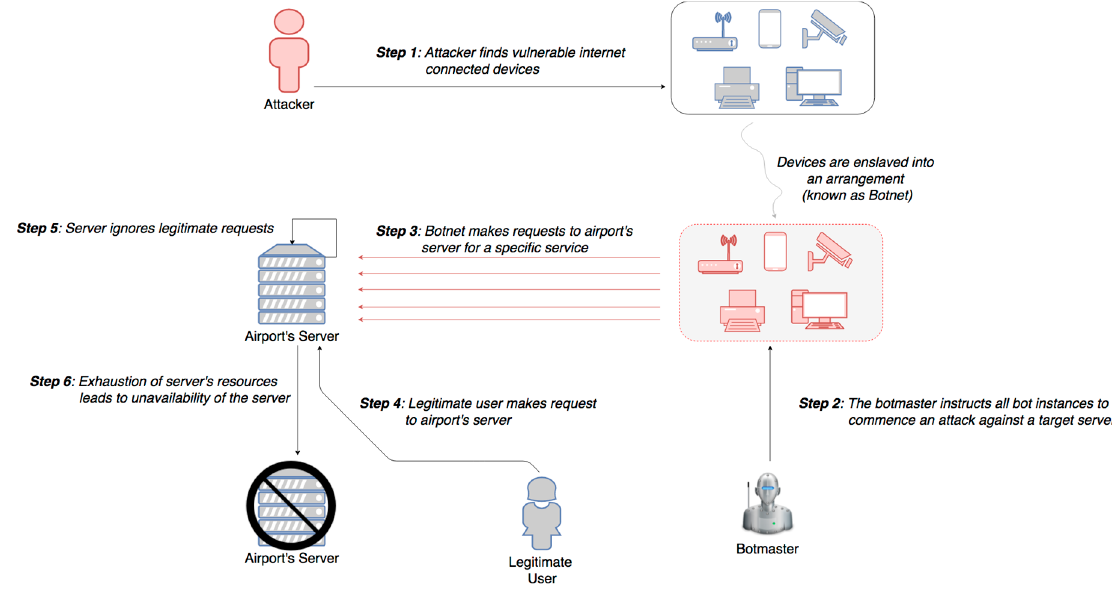
Figure 7. DDoS attack using Botnets